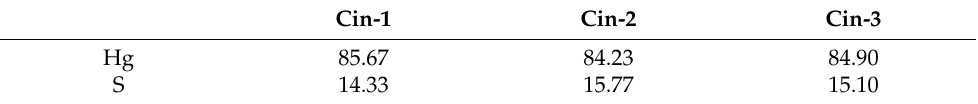
Figure 10. Principle PTE carrier minerals found in the investigated salina samples. Key: Cin—cinnabar ( a ), CuS x —copper sulphide ( b ) and Bi-oxide ( c ). Table 7. Elemental composition of analysed cinnabar grains. Data given in